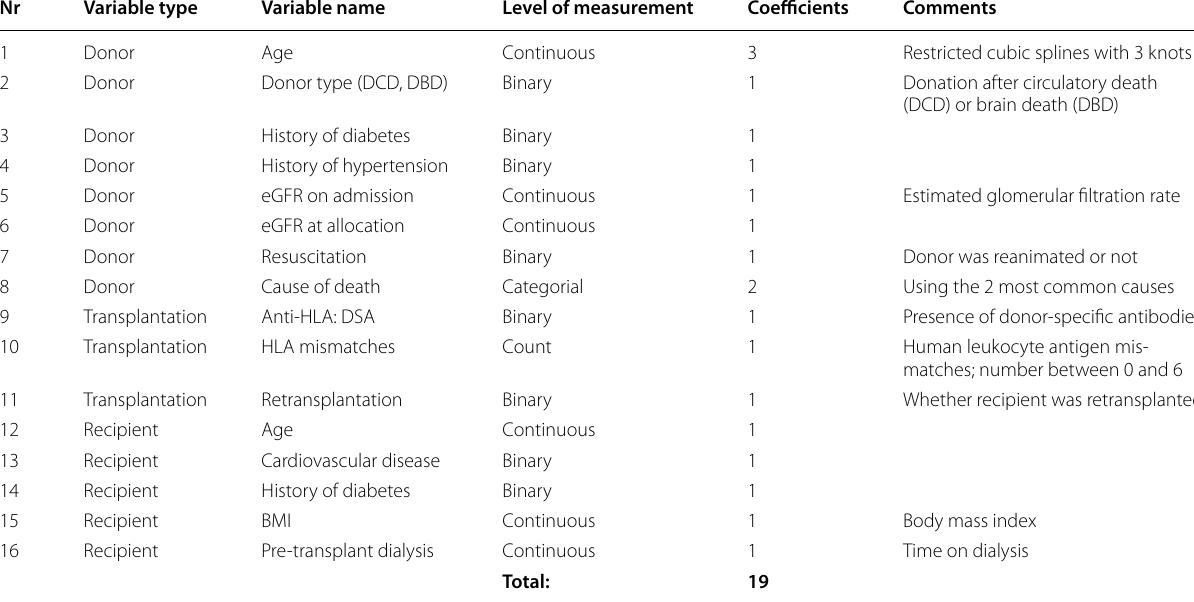
Table 2 Clinical candidate predictors for model development with the number of coefficients to be estimated. The sum of the number of coefficients to be estimated was based on a sample size calculation for clinical prediction